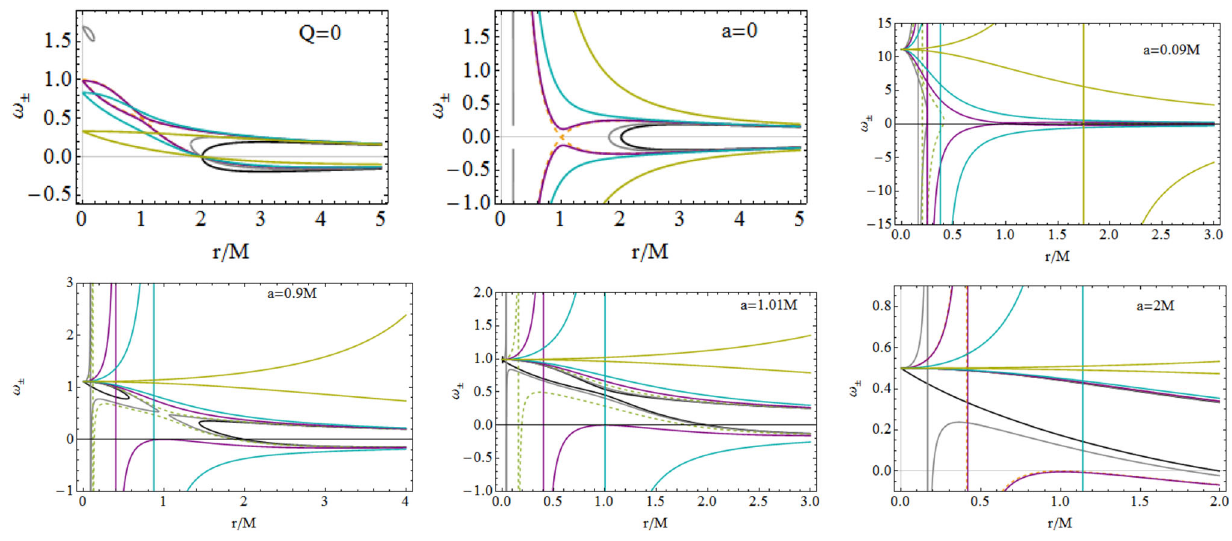
Fig. 26 Equatorial plane of the Kerr–Newman spacetime: the frequen- cies ω ± given in Eq. (34) as functions of r / M for different values of the charge Q / M and spin a / M . The limiting cases of the Kerr spacetime ( Q = 0) is shown in the first upper left panel and the static Reissner– Nordström geometry with a = 0 is the second left upper panel. The